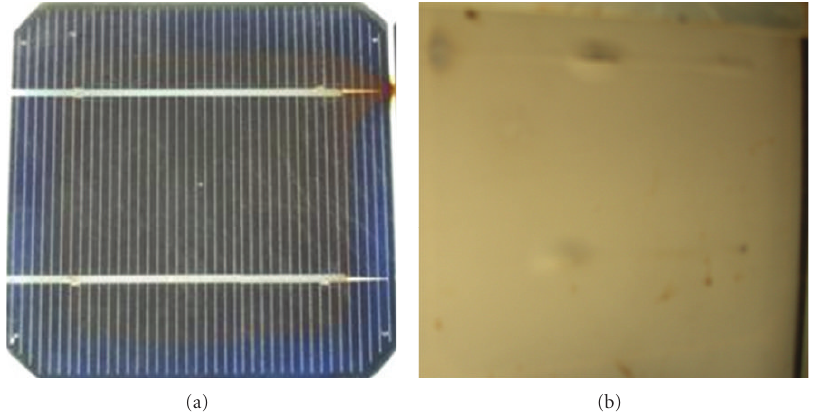
Figure 7: Digital image (a) front and (b) back, of a SIEMENS M55 c-Si cell exhibiting browning, degradation at bus bars and solder bond, and the appearance of blisters at the back sheet tedlar cover.